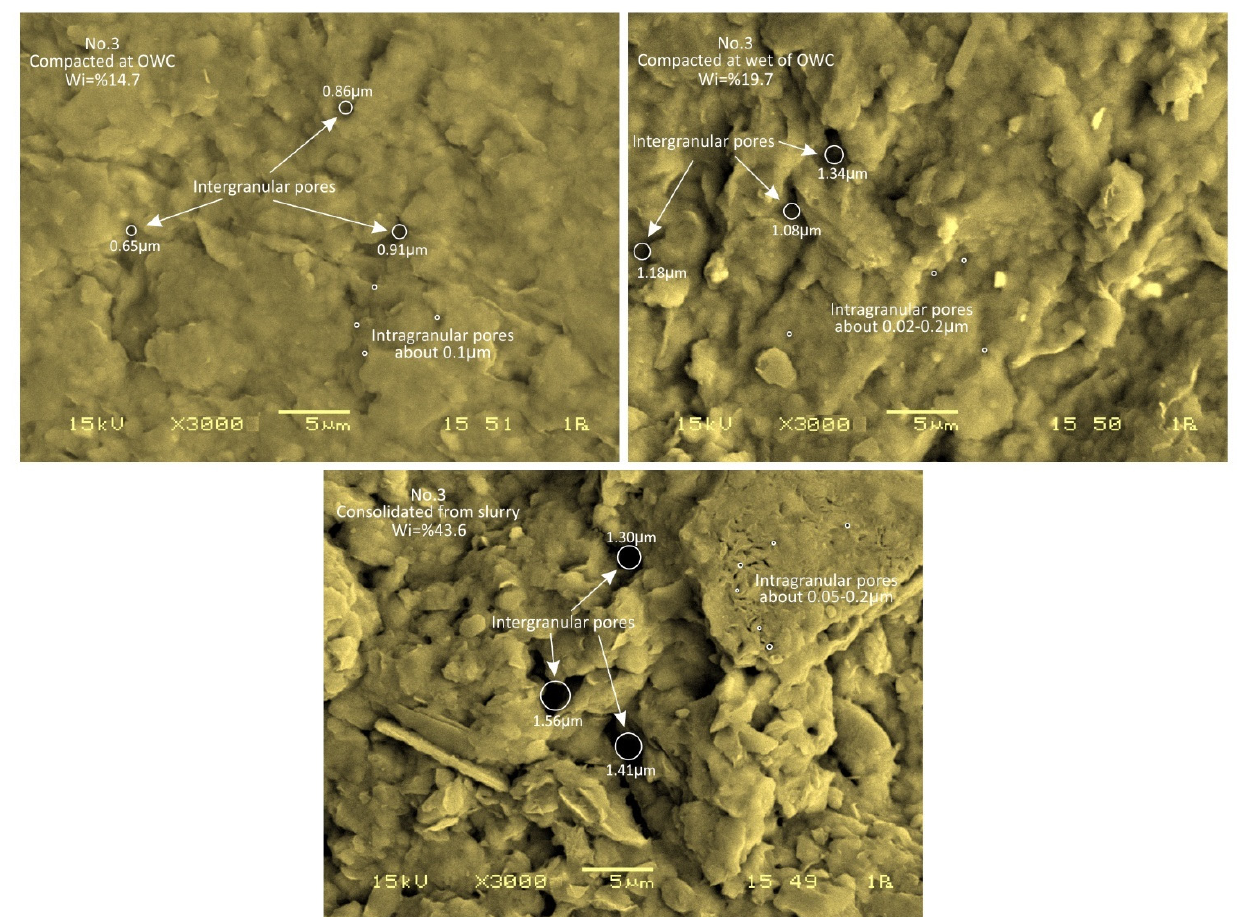
Figure 12. Measurement of pore diameters with a scanning electron microscope of No. 3.